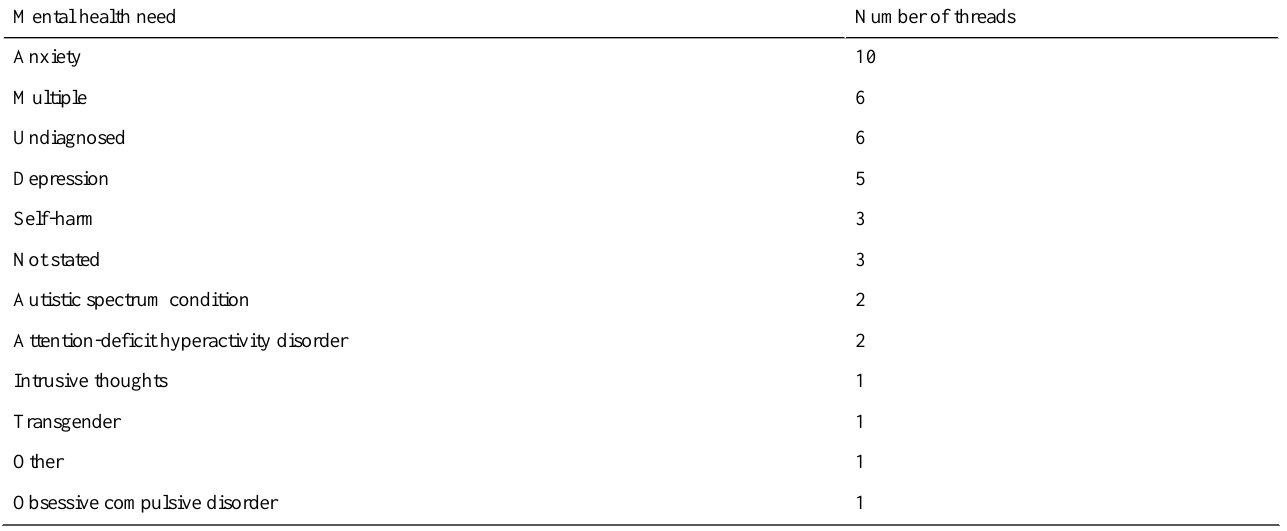
Table 1. The number of threads discussing each mental health